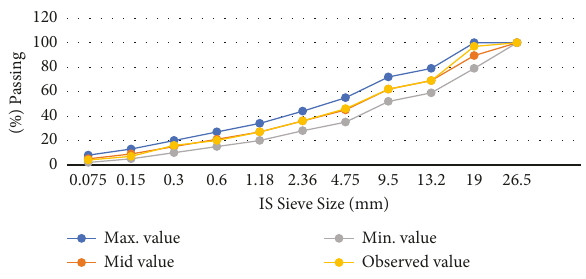
Figure 3: Aggregate gradation of bituminous concrete (BC) mix. Table 8: Physical Properties of 85/100 grade bitumen.